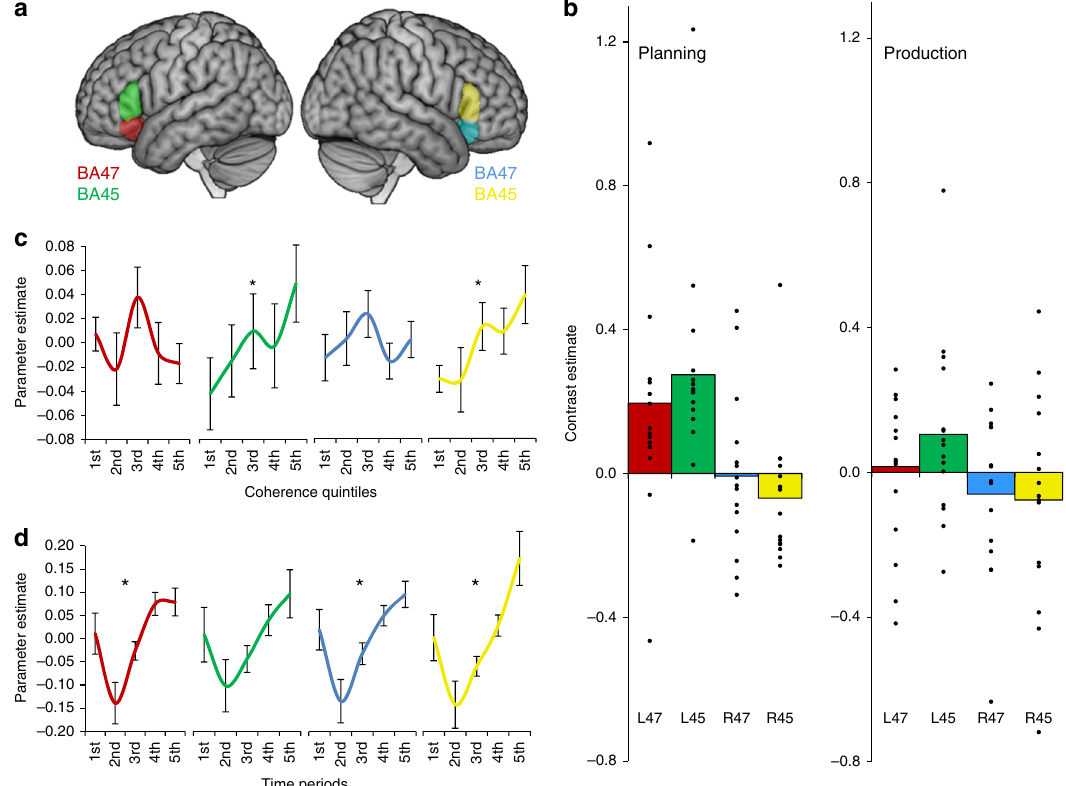
Fig. 3 Results in prefrontal regions of interest. a Anatomical ROIs were speci fi ed for left BA47 (red), left BA45 (green), right BA47 (blue) and right BA45 (yellow). b Estimates for contrasts of extended speech over automatic speech (points represent individual participants). c Effects of coherence on activation in each ROI. Speech blocks were divided into fi ve sets based on their coherence (where 1st quintile = least coherent responses and 5th quintile = most coherent). Estimates for each set are relative to the overall speech-related activation for the region. A signi fi cant linear effect of coherence was observed in left and right BA45 (asterisks indicate p < 0.05; one-sample t -test). d Change in activation over time within speech production periods. Speech blocks were divided into fi ve sets based on their temporal position in the speech elicitation period (where 1st = fi rst 10 s and 5th = fi nal 10 s). All regions except left BA45 showed a linear effect of time on activation (asterisks indicate p < 0.05; one-sample t -test). Bars indicate standard error of the